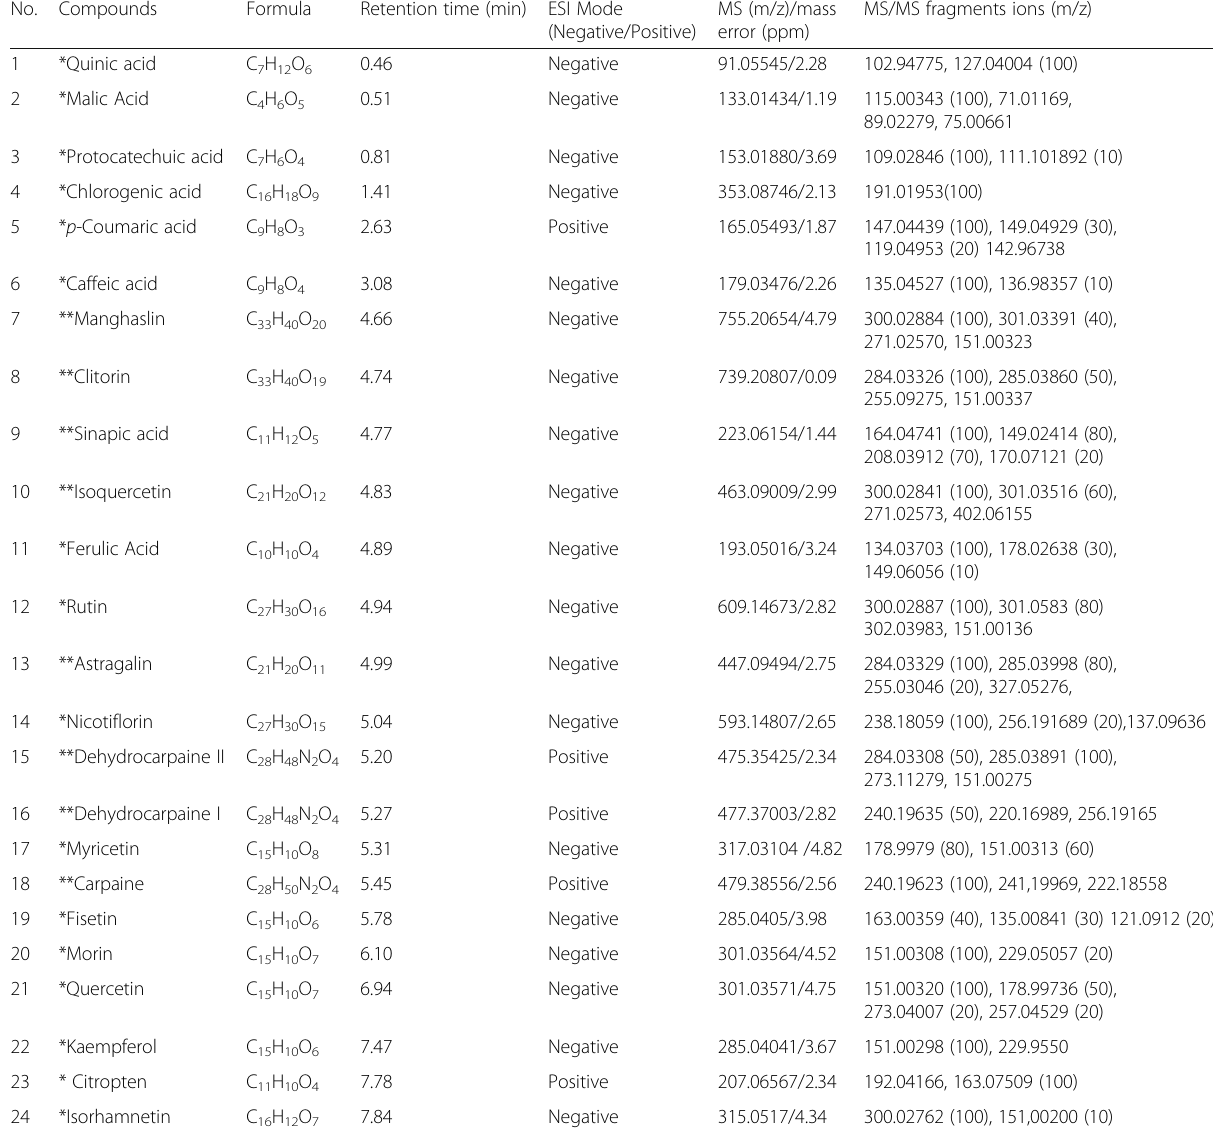
Table 1 Compounds identification of freeze-dried C. papaya leaf juice by UPLC-HRAMS analysis No. Compounds